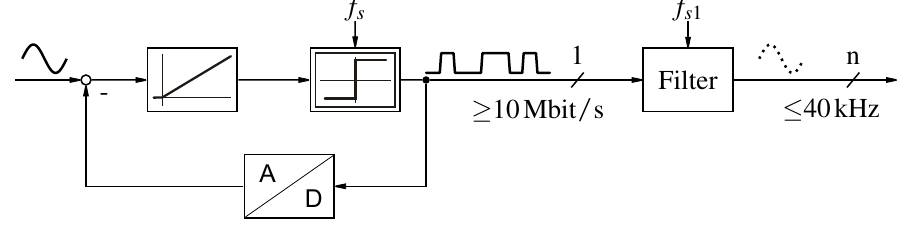
Figure 1. First-order ∆Σ -modulator with low-pass filter.